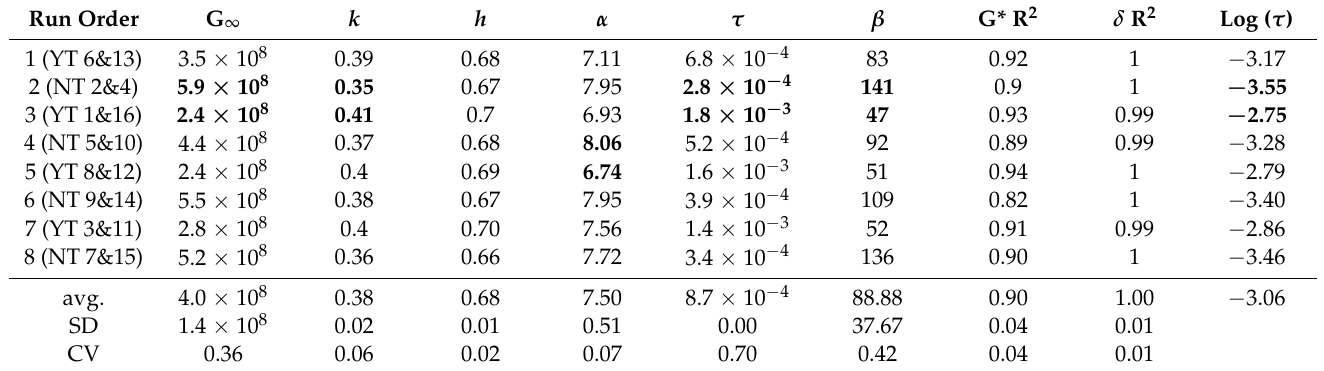
Table 10. The 2S2P1D model parameters for all runs for 50/70. Statistically significant differences between runs are denoted in bold.